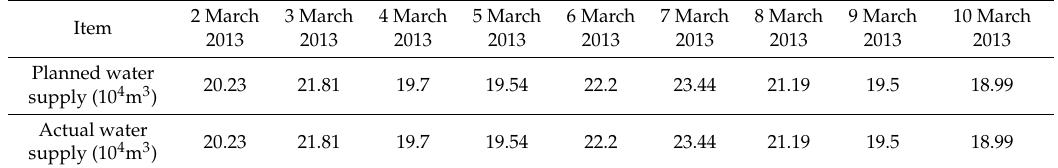
Table 7. The water dispatching process of the Changliubi waterworks.